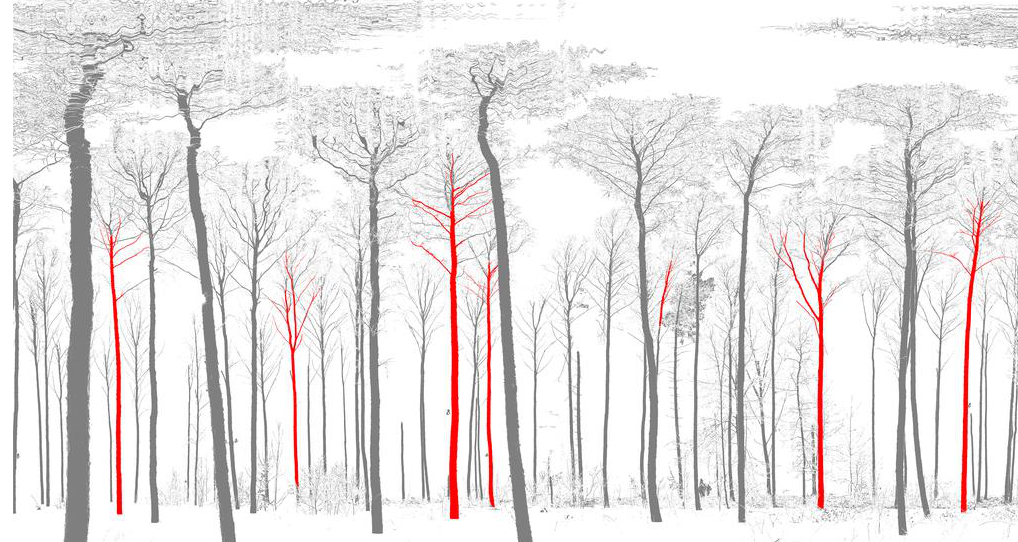
Figure 9. Raster data of a single scan. Connected components are colored in gray. Components that correspond to the panels in figure 10 are highlighted in red.